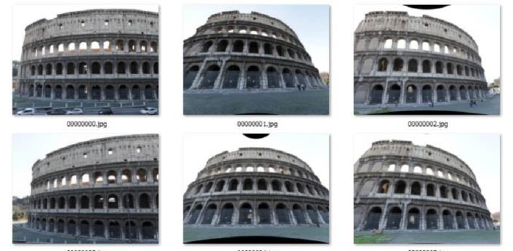
Figure 14. Automated restitution of 3D points by SfM. In green and red are visualized the computed acquisition points